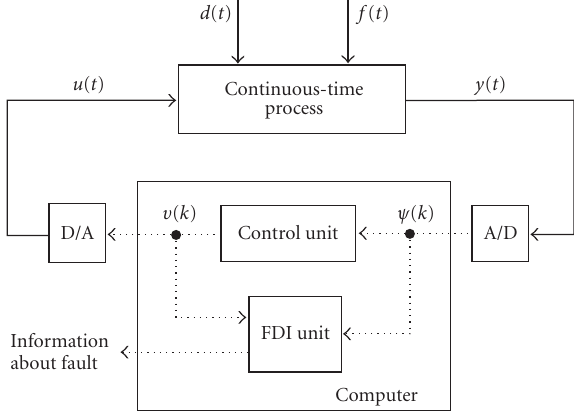
Figure 1: Schematic description of the application of an FDI system in a process control